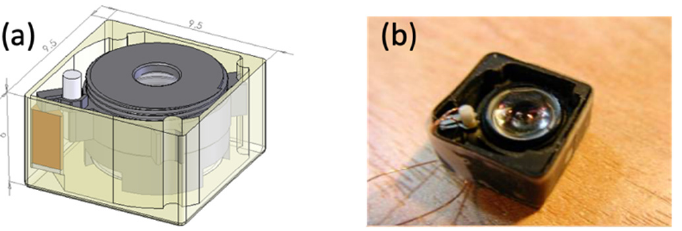
Figure 5. AF module with a Lobster USM. ( a ) The design. ( b ) The prototype with dimensions of mm × 9.50 mm × 6 mm. 9.50 mm × 9.50 mm × 6 mm.